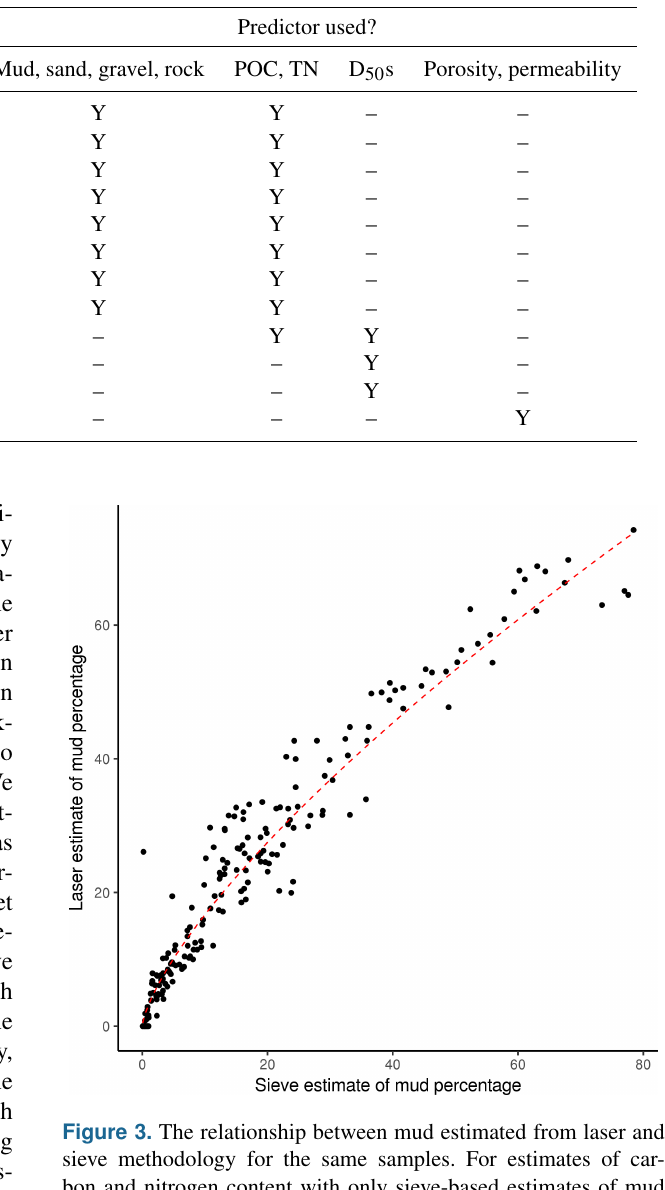
Table 3. Predictors used for statistical models for predicting sediment parameters. When mud, sand and gravel percentages and whole- sediment median grain sizes were used as predictors, raw field data were used in the creation of the statistical models, whereas the synthetic maps created in this study were used for model predictions.